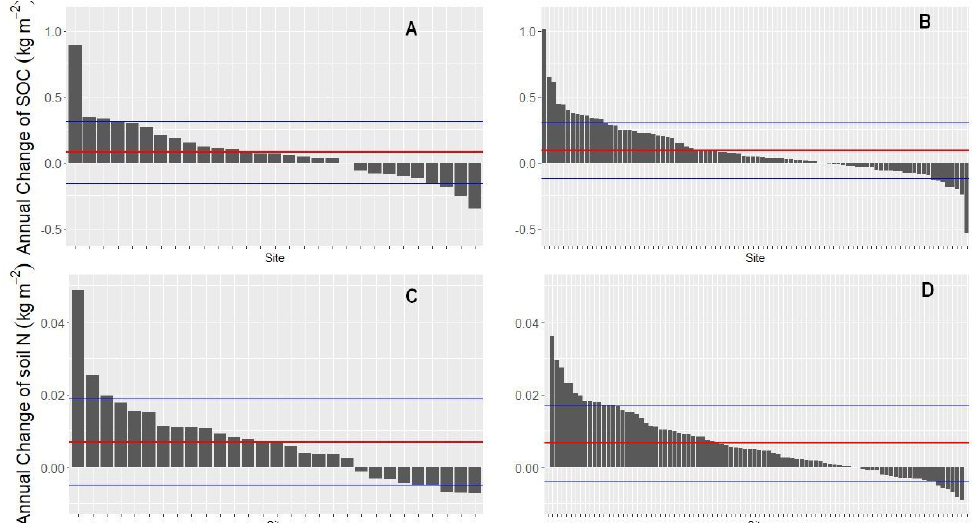
Figure 2. Annual change of organic carbon and nitrogen stocks in Austrian forest soils on 139 sampled sites ordered according to size of the change in the respective stocks. The thick horizontal red line shows the mean annual change, the fine horizontal blue lines show the mean ± the standard deviation. The annual change of organic carbon is shown in ( A ) for sites on calcareous bedrock and ( B ) for sites on silicatic bedrock. The annual change of nitrogen is shown in ( C ) for sites on calcareous bedrock and ( D ) for sites on silicatic bedrock.